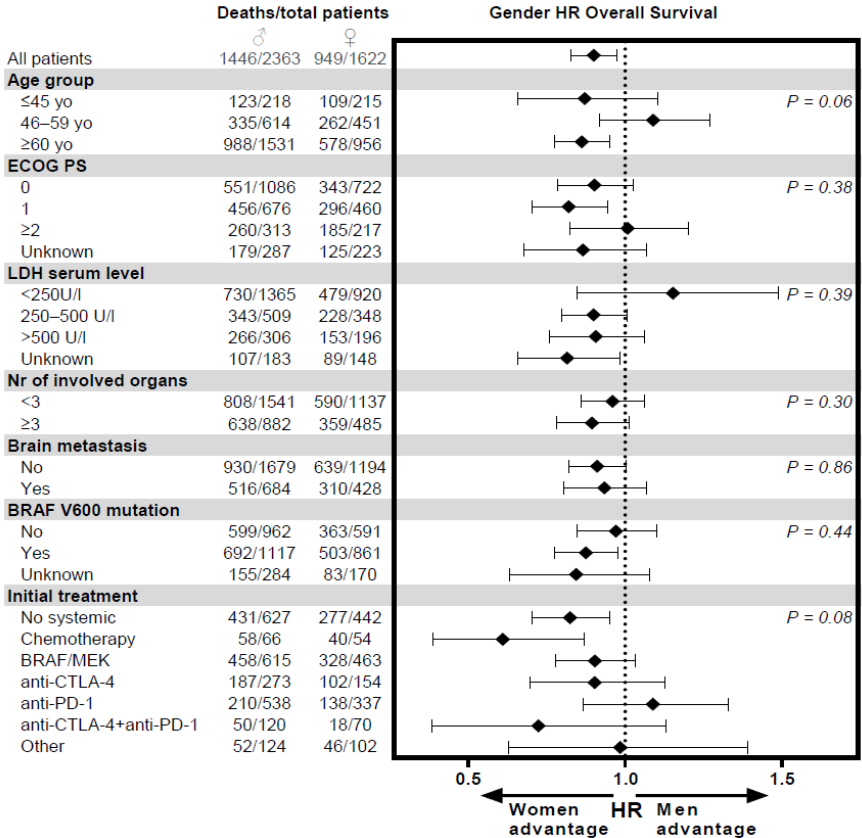
Figure 4. Subgroup analyses for overall survival. Subgroup analyses presented show crude sex